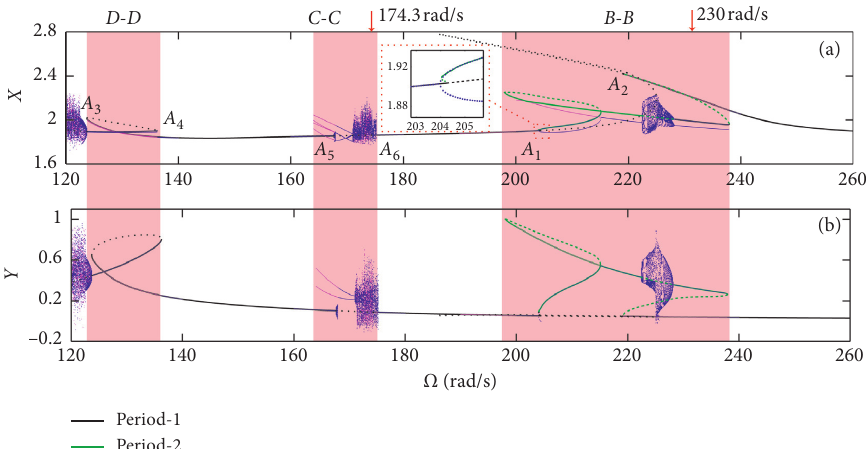
Figure 4: Numerical bifurcation diagram of (a) X ( τ ) and (b) Y ( τ ) when Ω is sweeping up (blue dots) and down (magenta dots) for δ 0 � 6.0 μ m and (c) � 200Ns/m.